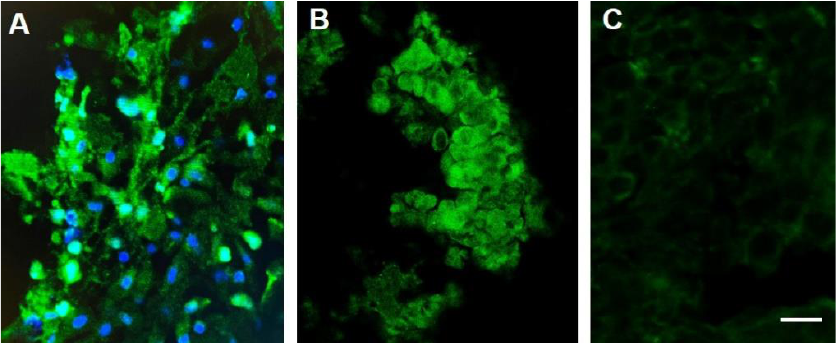
Figure 2. Sodium channel labeling in biopsy samples obtained from a patient with stage IIB squa- mous cell carcinoma (SCCA) of the cervix ( A ) and a companion canine ( B , C ) before ( A , B ) and after ( C ) treatment with TOL. The photomicrographs depict the immunohistochemical labeling of VGSCs (green) in a biopsy of the cervical malignancy ( A ) and a canine nasopharyngeal adenocarcinoma ( B ), before ( A,B ) and after ( C ) treatment with TOL. Nuclei are counterstained with DRAQ5 (blue). Note that the number of cells in a post-treatment biopsy sample obtained after a single treatment of the canine adenocarcinoma with TOL ( C ) that highly express VGSCs is significantly reduced. The number of cells that had expressed fewer VGSCs and pumps pre-treatment were unaffected and comprised the remaining amount of tumor. Calibration bar in C = 50 µm.